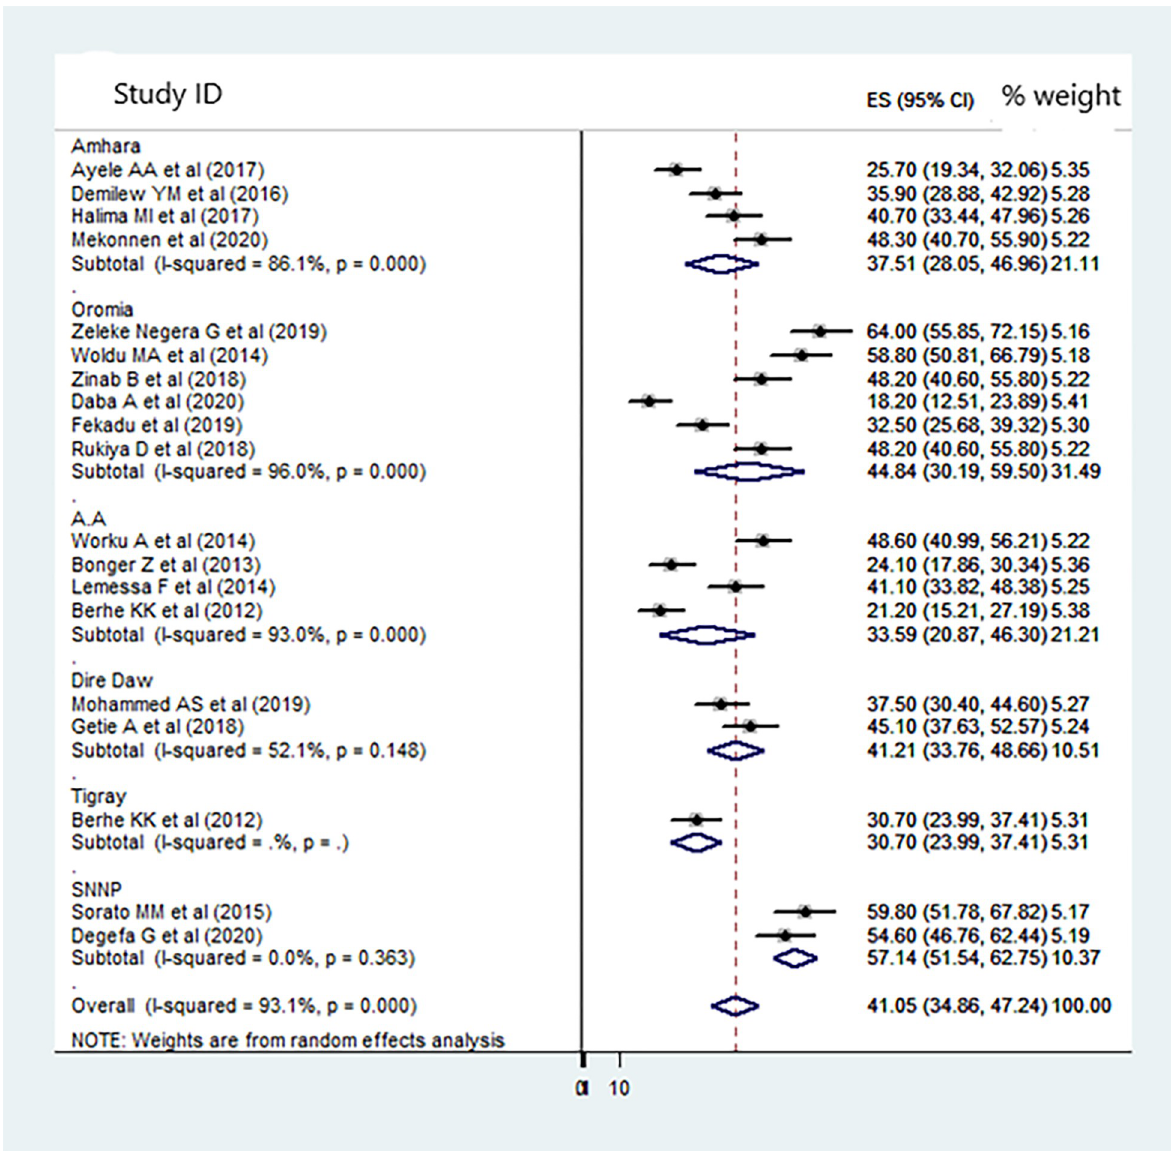
Fig 2. A subgroup analysis of the forest plot showing the pooled proportion of dietary adherence among type 2 DM in Ethiopia,